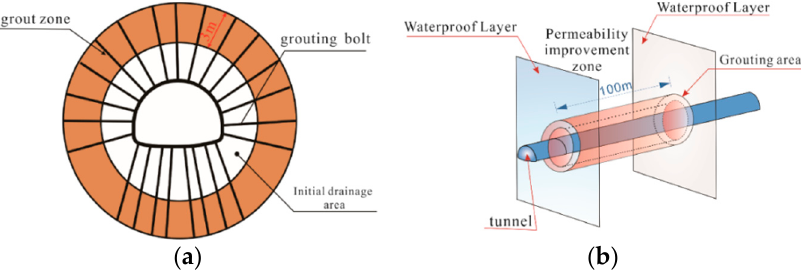
Figure 16. The schematic diagram of the multiple times grouting in the on-site test. ( a ) Grouting bolts layout; ( b ) grouting rendering.